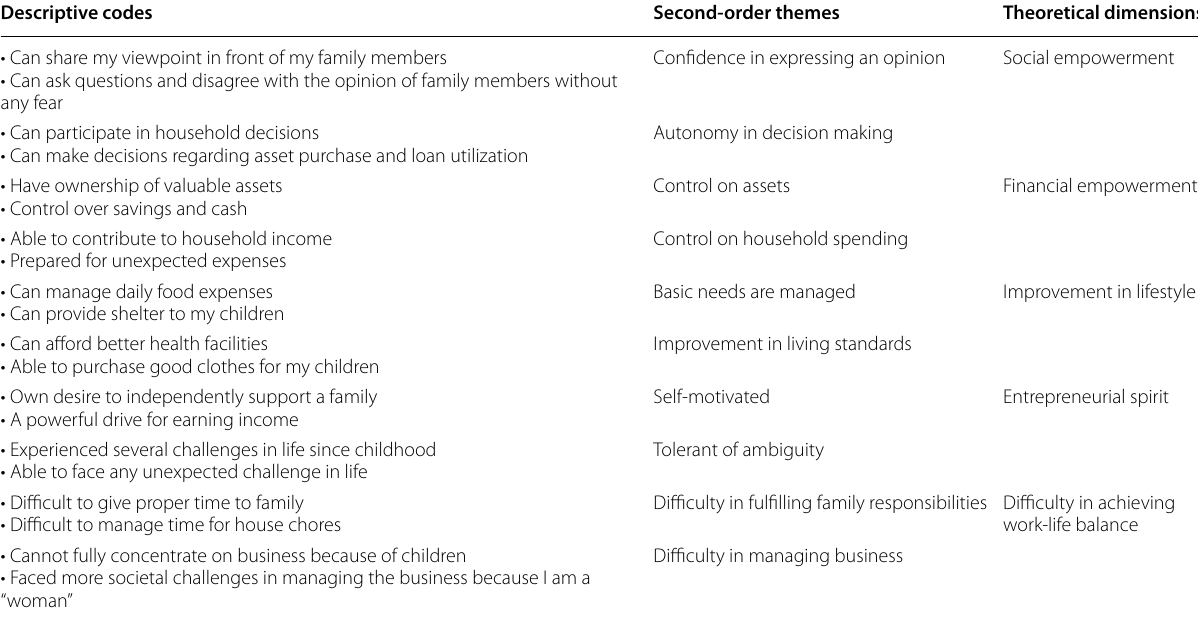
Table 3 Overview of data structure Descriptive